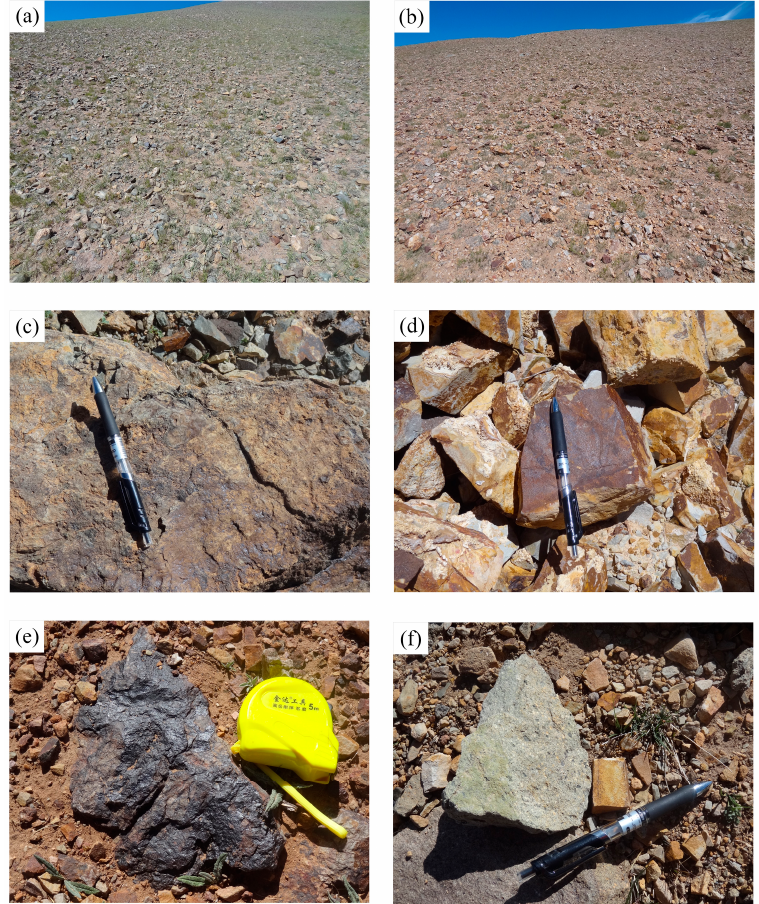
Figure 8. The field photographs of the study areas. ( a ) regional view of propylitic zone of Duobuza PCD in site 2; ( b ) regional view of phyllic zone of Duobuza PCD in site 1; ( c ) ferruginization in propylitic zone of Duobuza PCD in site 4; ( d ) ferruginization and kaolinization in phyllic zone of Bolong PCD in site 7; ( e ) ferruginization of cryptoexplosion breccia in phyllic zone, Bolong PCD, site 10; ( f ) granodiorite-porphyry outcrop in site 9. For the geographical location of the sites see Figure 4. Mapping results of using RBD (B5 + B7)/B6 of ASTER SWIR bands [25,32,60] and MTMF of ASTER SWIR bands 4–9 reflect the spatial distribution of chlorite and epidote that are the main